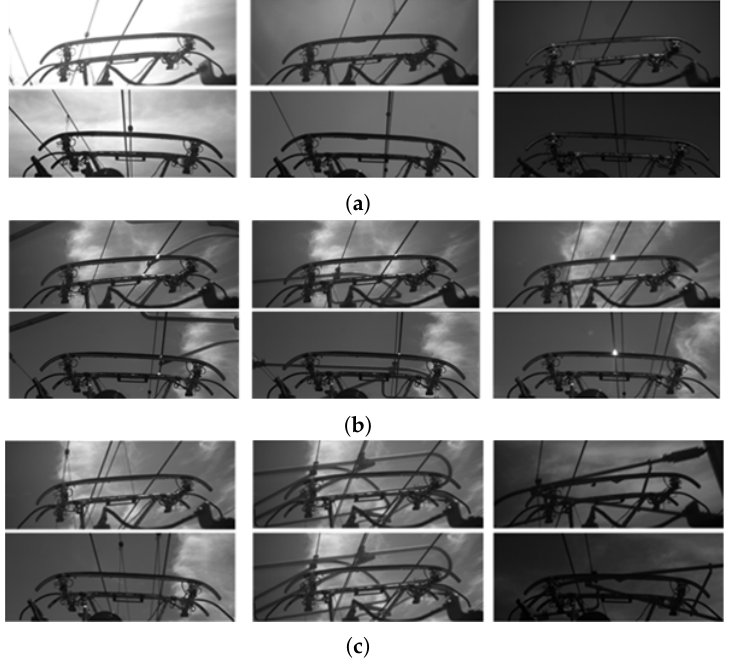
Figure 6. The tested datasets which contains various complex situation. ( a ) Image in different illumination, ( b ) illustration of sparks in PCS images, and ( c ) an example of complex